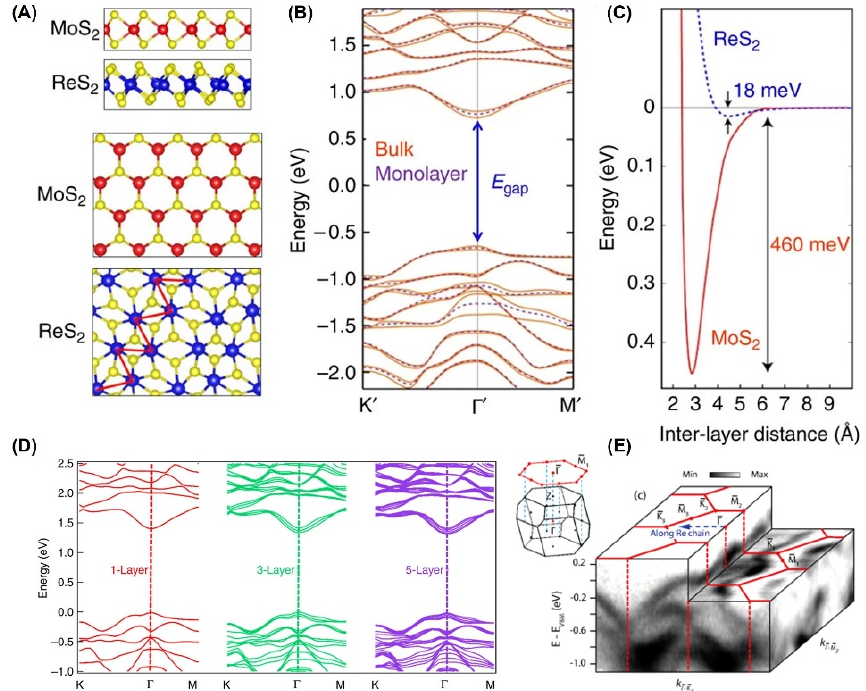
Figure 3. ( A ) Top and side view of single-layer crystal structures of side (top two panels) and top view (bottom two panels) of ReS 2 with T d crystal structure compared with the 1 H structure of conventional monolayer TMDs. The Re atoms dimerize as a result of the Peierls distortion forming a Re chain denoted by the red zigzag line. ( B ) DFT calculated electronic band structure of bulk and monolayer ReS 2 . Both are predicted to be a direct bandgap semiconductor with nearly identical bandgap value at the Γ point. ( C ) The calculated total energy of the system as a function of interlayer separation. The significantly shallower depth of the well in ReS 2 implies much weaker interlayer coupling energy